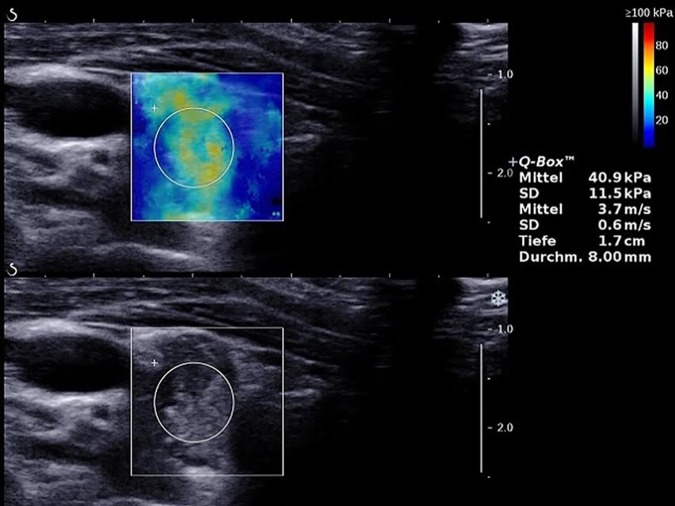
2D-SWE with the ROI placed within a thyroid nodule in the right thyroid lobe measuring a velocity of 3.7 m/s.Histology revealed papillary carcinoma.